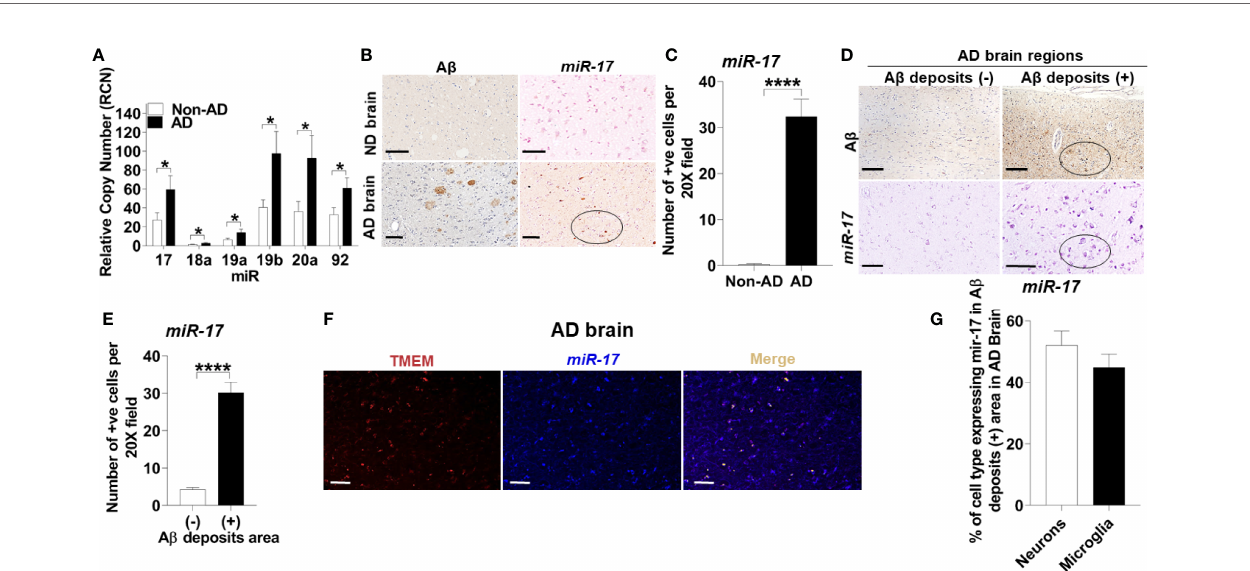
FIGURE 5 | The Mirc1/Mir-17-92 cluster is upregulated in human Alzheimer ’ s disease and is expressed in microglia. (A) Relative copy number of the six miRNAs of the miR-17-92 cluster in human AD brain tissue sections and their age-matched no disease controls (n = 15). Statistical analysis was performed using multiple unpaired two-tailed student ’ s t-test. (B) Representative images of A b deposits and in situ hybridization of miR-17 in adjacent brain tissue sections of human AD and no disease control. A region with multiple miR-17 positive cells is circled. Scale bar: 100µM. (C) Quanti fi cation of cells expressing miR-17 represented in (B) . Values are mean ± SEM calculated by scoring 3 randomly chosen 20x fi elds of view (n = 4). Statistical analysis was performed using unpaired two tailed Student ’ s t-test. (D) Representative images of in situ hybridization of miR-17 in A b deposits negative (-) and positive (+) area of AD brain tissue sections. Images of A b are adjacent tissue sections to corresponding miR-17 images. A region with multiple miR-17 positive cells and corresponding A b deposits section is circled. Scale bar: 100µM. (E) Quanti fi cation of images represented in (D) as described in (C) (N = 4). (F) Representative images of the co-expression analysis of in situ hybridization of miR-17 (blue) and Immunohistochemistry of TMEM (as selective marker for microglia) (red) with merge image completed by nuance processing in an A b deposits positive area of AD brain tissue sections. Colocalization in the merge image is shown in yellow. Scale bar: 100µM. (G) Percentage of the neurons and microglia expressing miR-17 in A b deposits positive area of AD brain tissue sections (n = 3). *p ≤ 0.05, ****p ≤